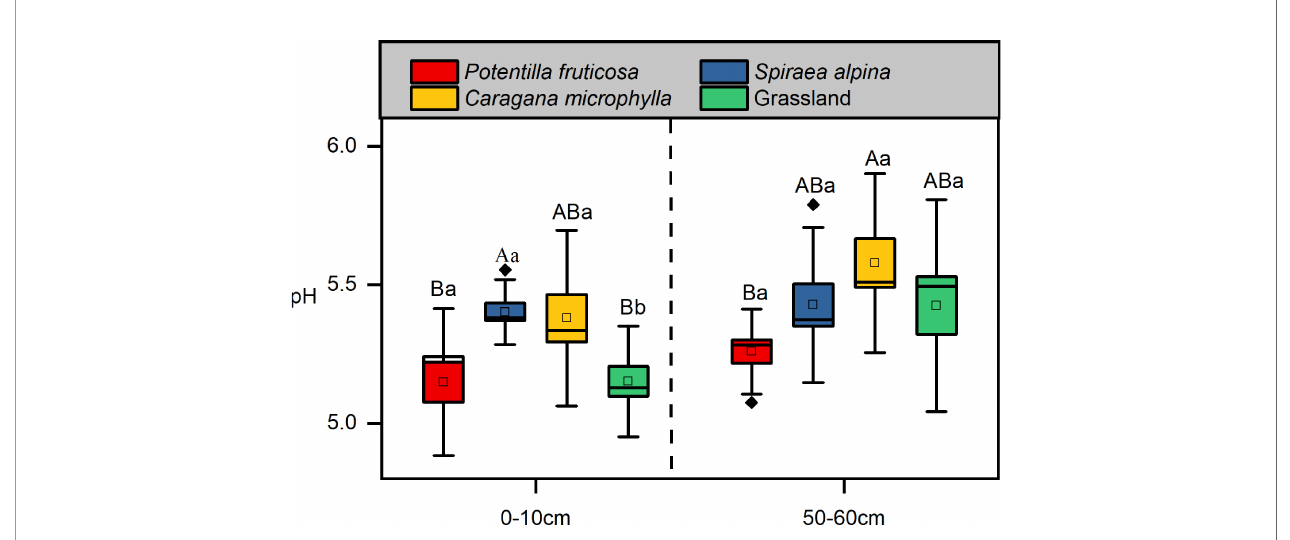
FIGURE 2 | Soil pH. Different lowercase letters indicate signi fi cant differences between the different soil layers within the same vegetation types ( p < 0.05, independent-samples t-test). Different uppercase letters indicate signi fi cant differences between the different vegetation types within the same soil layers ( p < 0.05, Tukey ’ s HSD